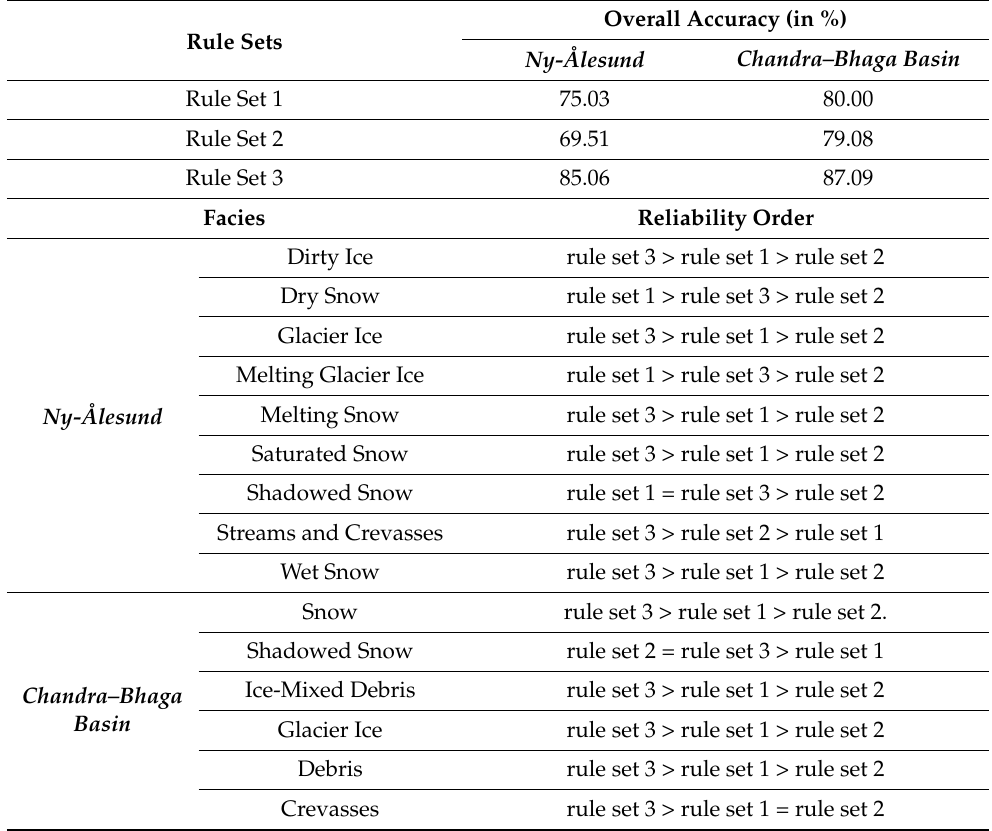
Table 5. Overall accuracy (OA) of the classification of surface facies across both study sites using the three rule sets. The OA is calculated as an average across all processing schemes. Reliability orders based on the OA and variances represent the best rule set for mapping the individual